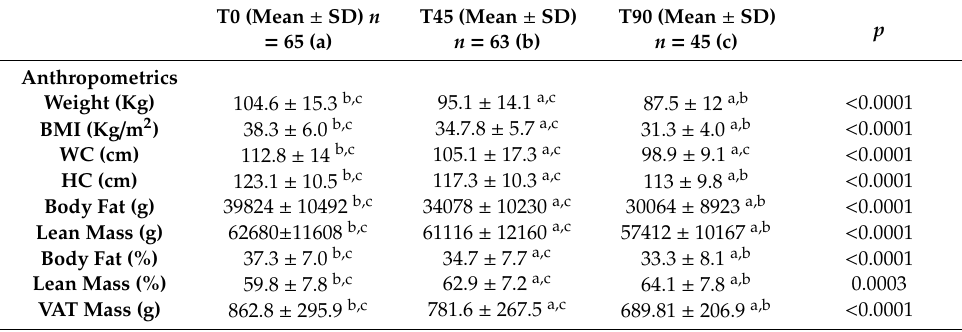
Table 1. Participants characteristics at baseline (T0), after the very low calorie ketogenic diet (VLCKD)-phase (T45) and the low calorie diet (LCD)-phase (T90). Variables with normal distribution are expressed as mean ± SD, those with non-normal distribution as median (interquartile